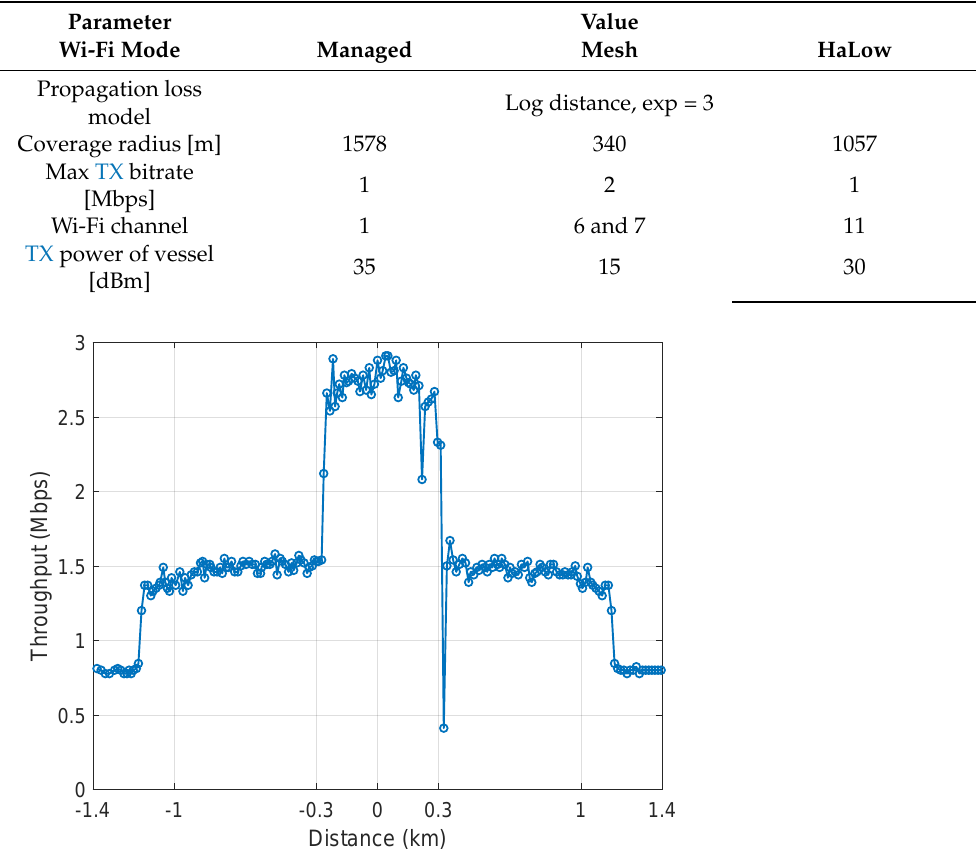
Table 2. Default parameters used in communication bootstrapping evaluation.